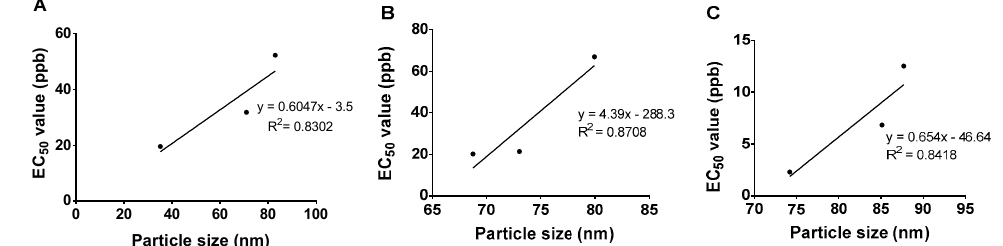
Figure 11. The relationship between the particle size and the EC 50 values of the as-synthesized hexaconazole-micelle nanodelivery systems: ( A ) HMBS; ( B ) HMDS; and ( C ) HMT towards G. boninense .